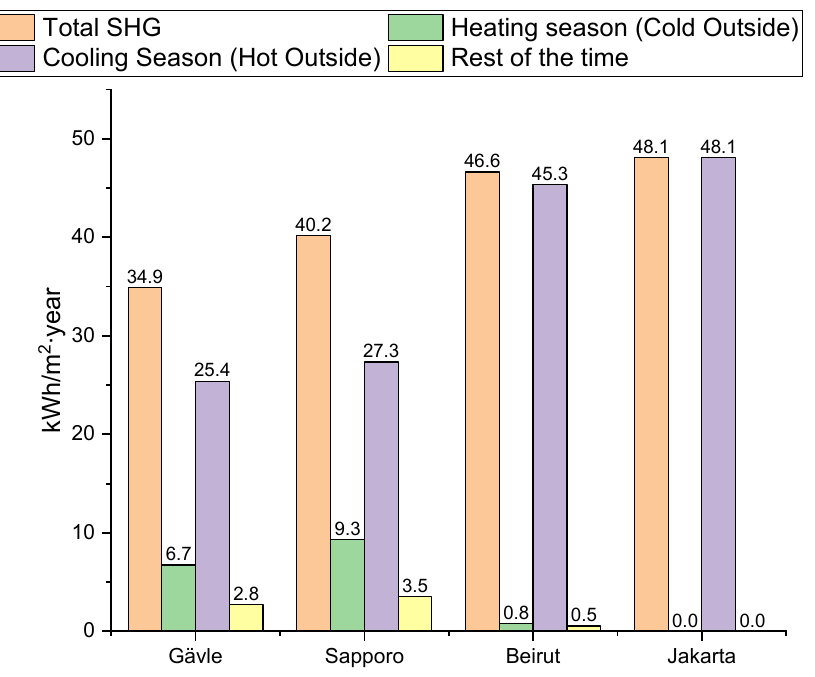
Figure 12. SHG for B0 in different locations.